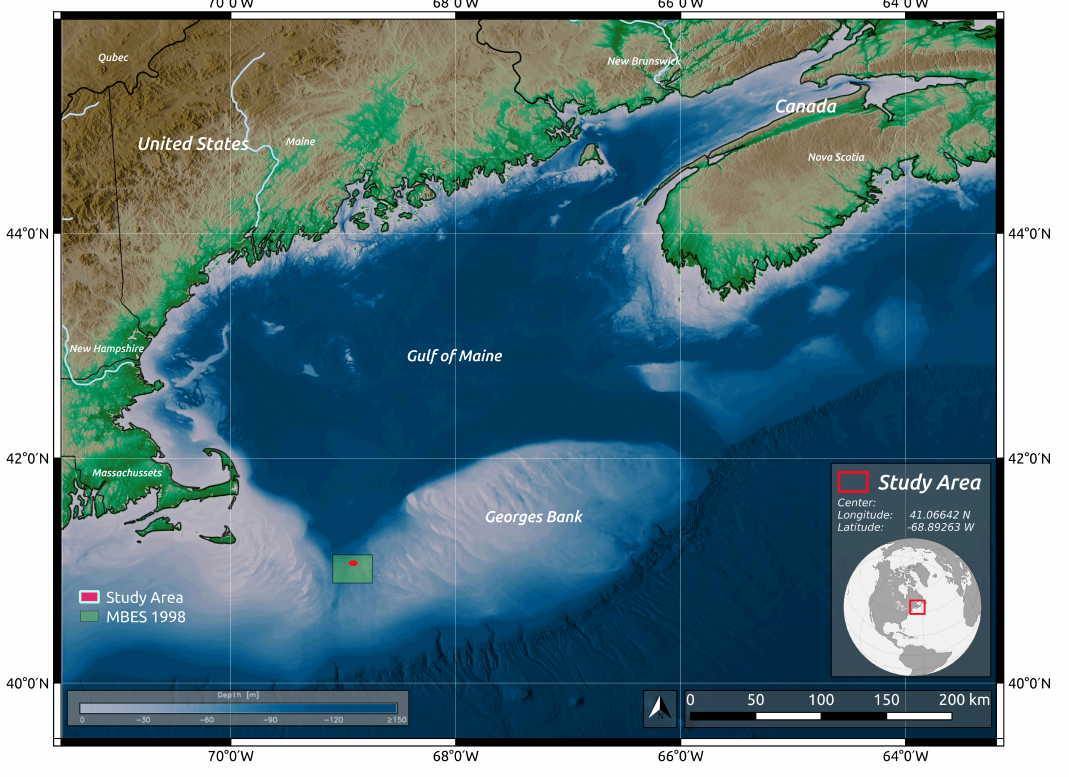
Figure 1. Location of the area of study (red circle), USGS MBES survey (1998) [23] (green area). The shaded relief used as background is derived from the 3 arc second digital elevation model of the Gulf of Maine, source: United States Geological Survey (USGS)—Coastal and Marine program, Woods Hole